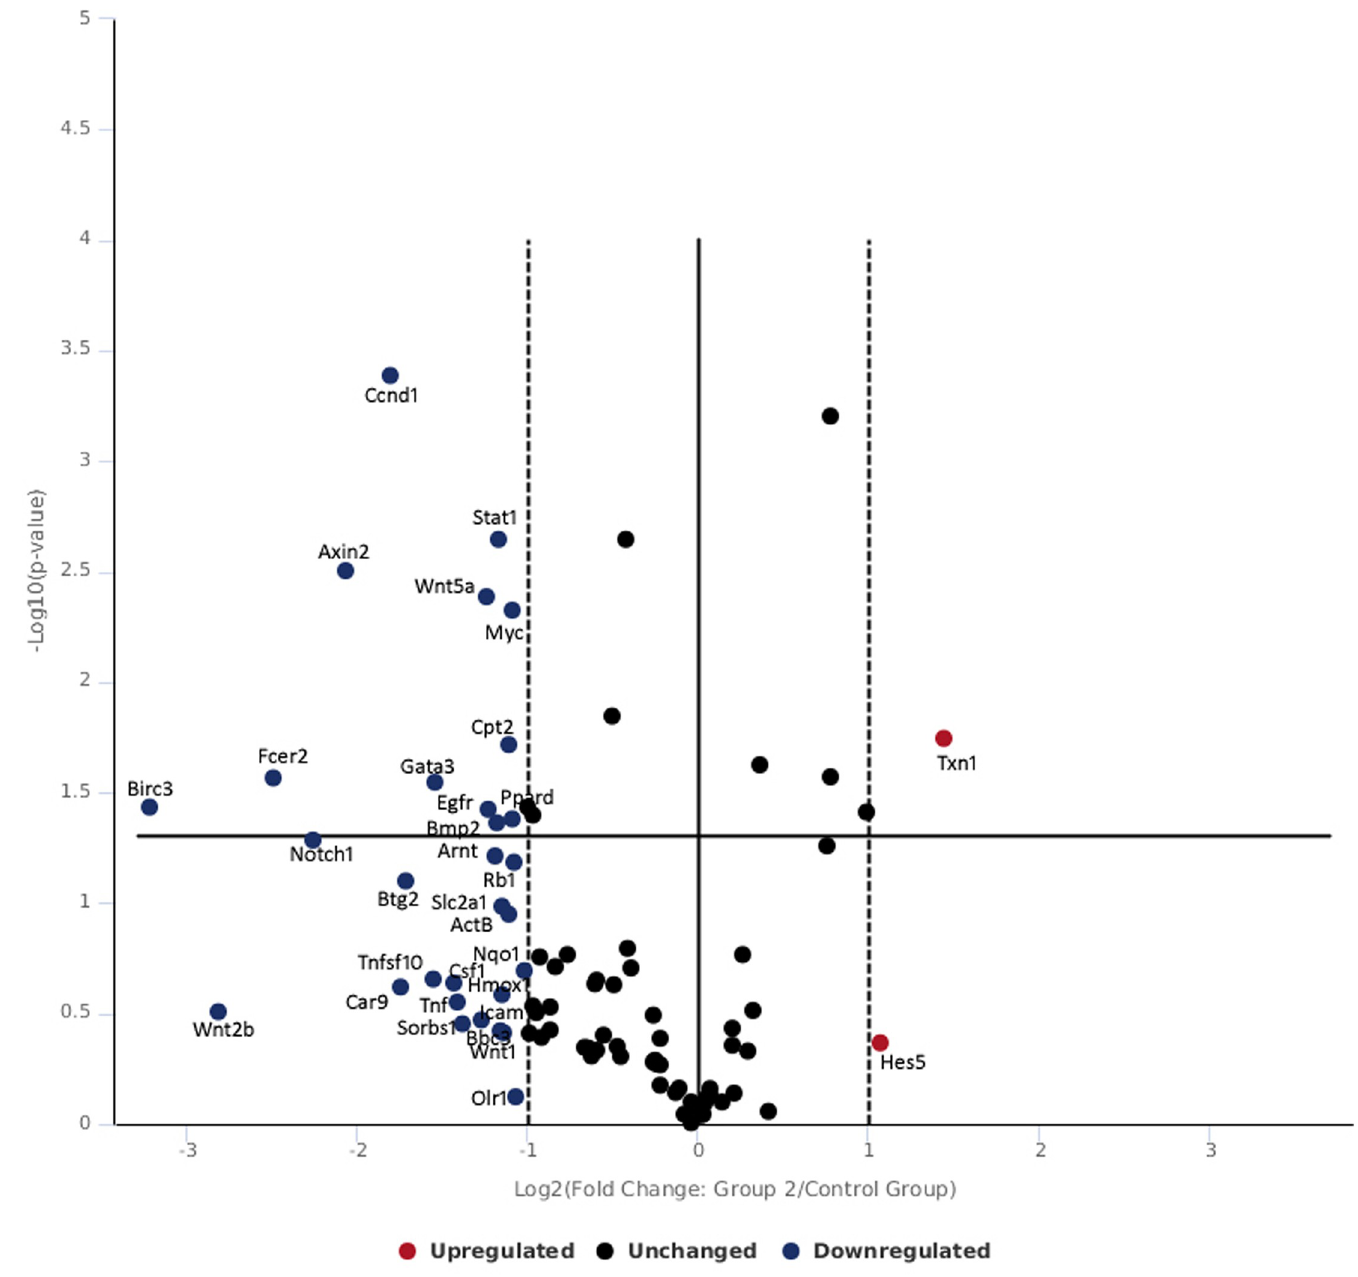
Fig 4. Volcano plot of genes expressed following 532 nm laser exposure at moderate irradiance of 0.25 W/cm 2 .